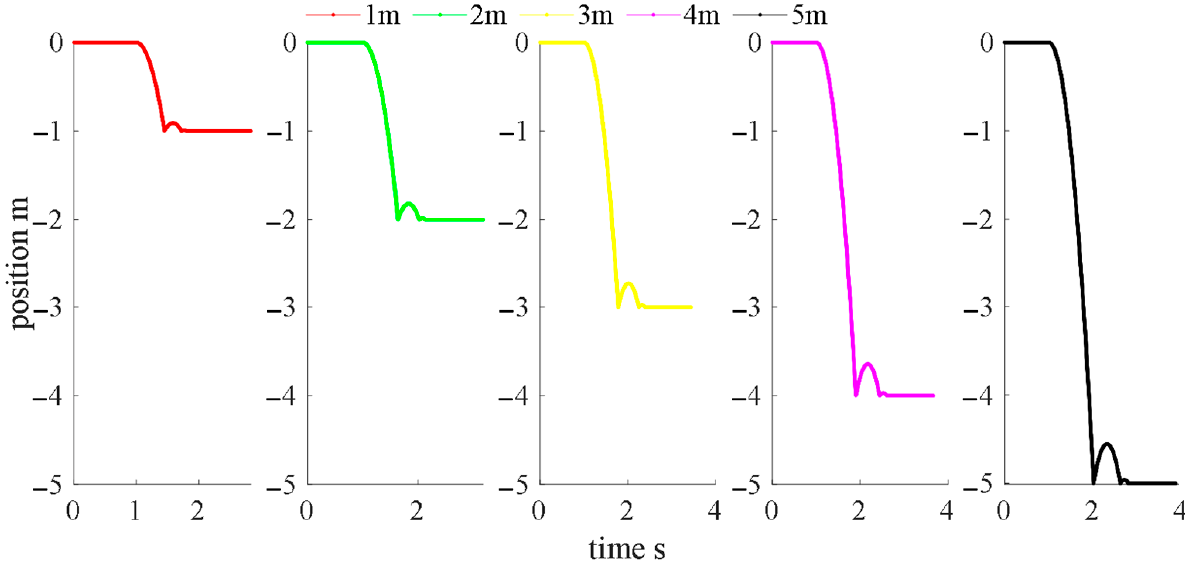
Figure 5. Falling trajectory simulation results.